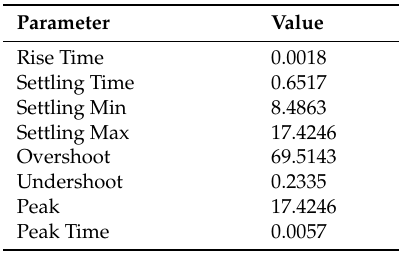
Table 3. Characteristics of the motor torque